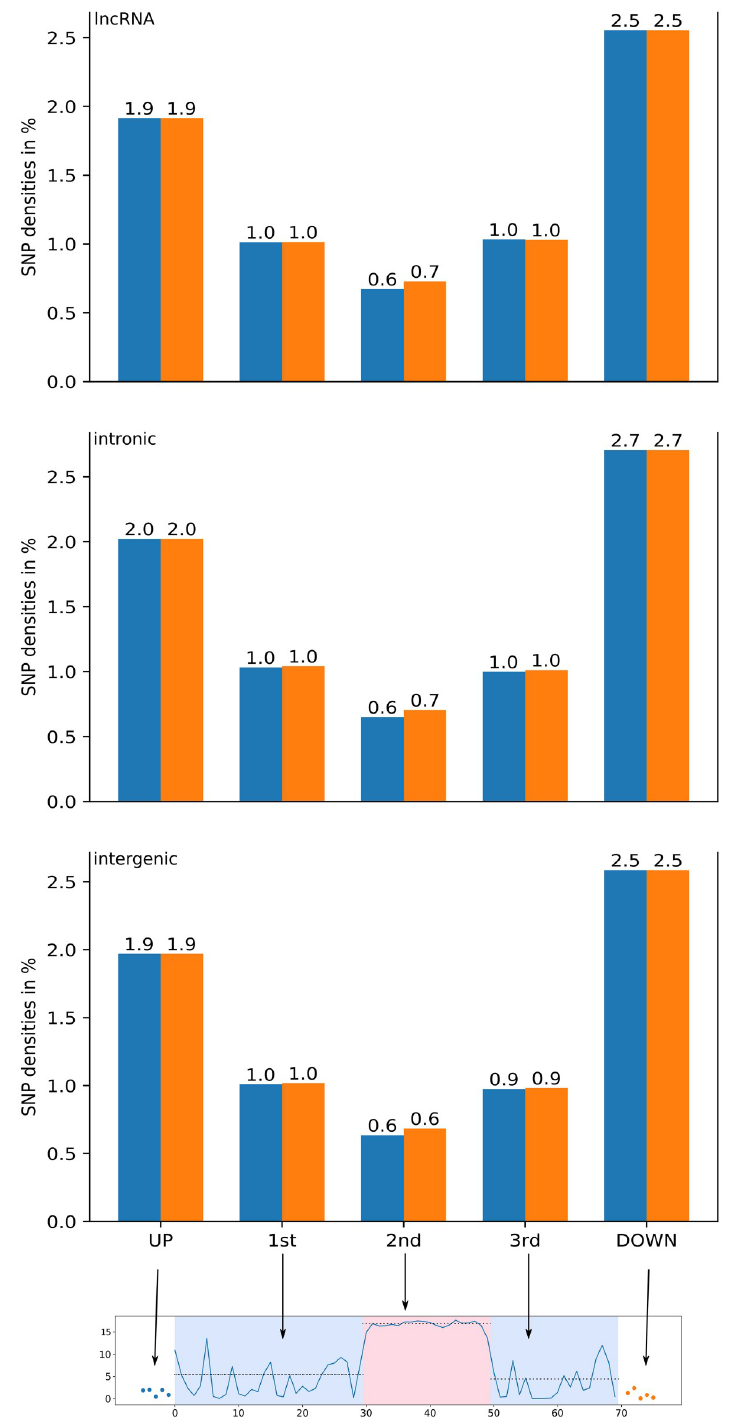
Fig 5. SNP densities computed for each section of the three different CNEs (lncRNA, intronic, intergenic). The orange bars represent the SNP densities for that section based on change points derived from the 23 sauropsids alignment PhastCons scores, the blue bars represent the SNP densities based on change points identified via chCADD.